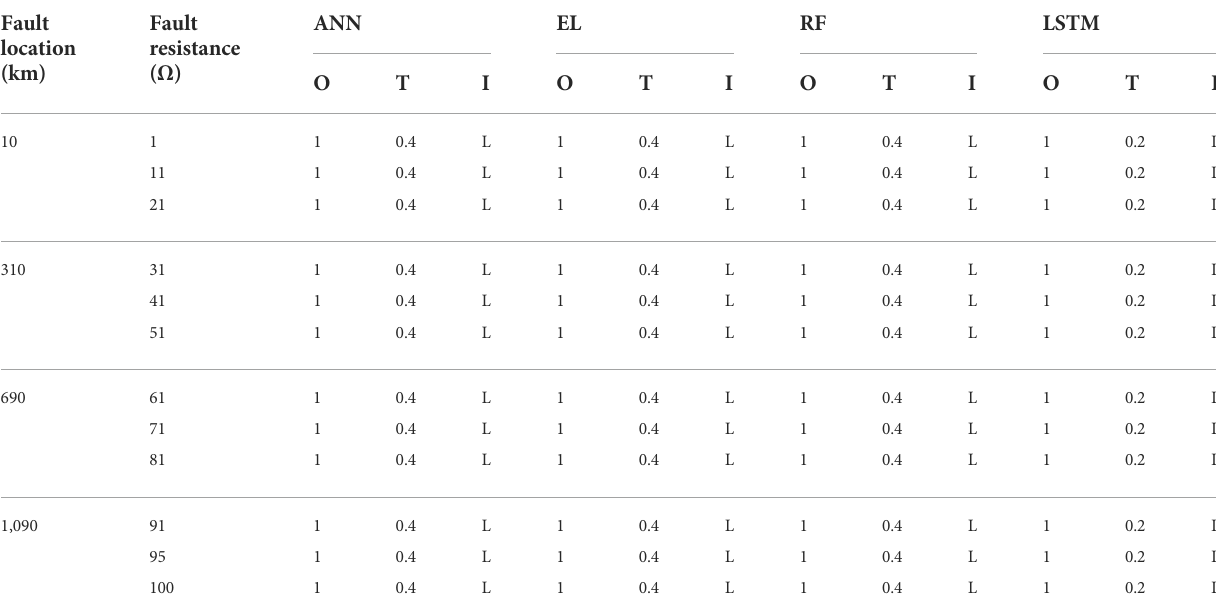
TABLE 5 Performance results with fault